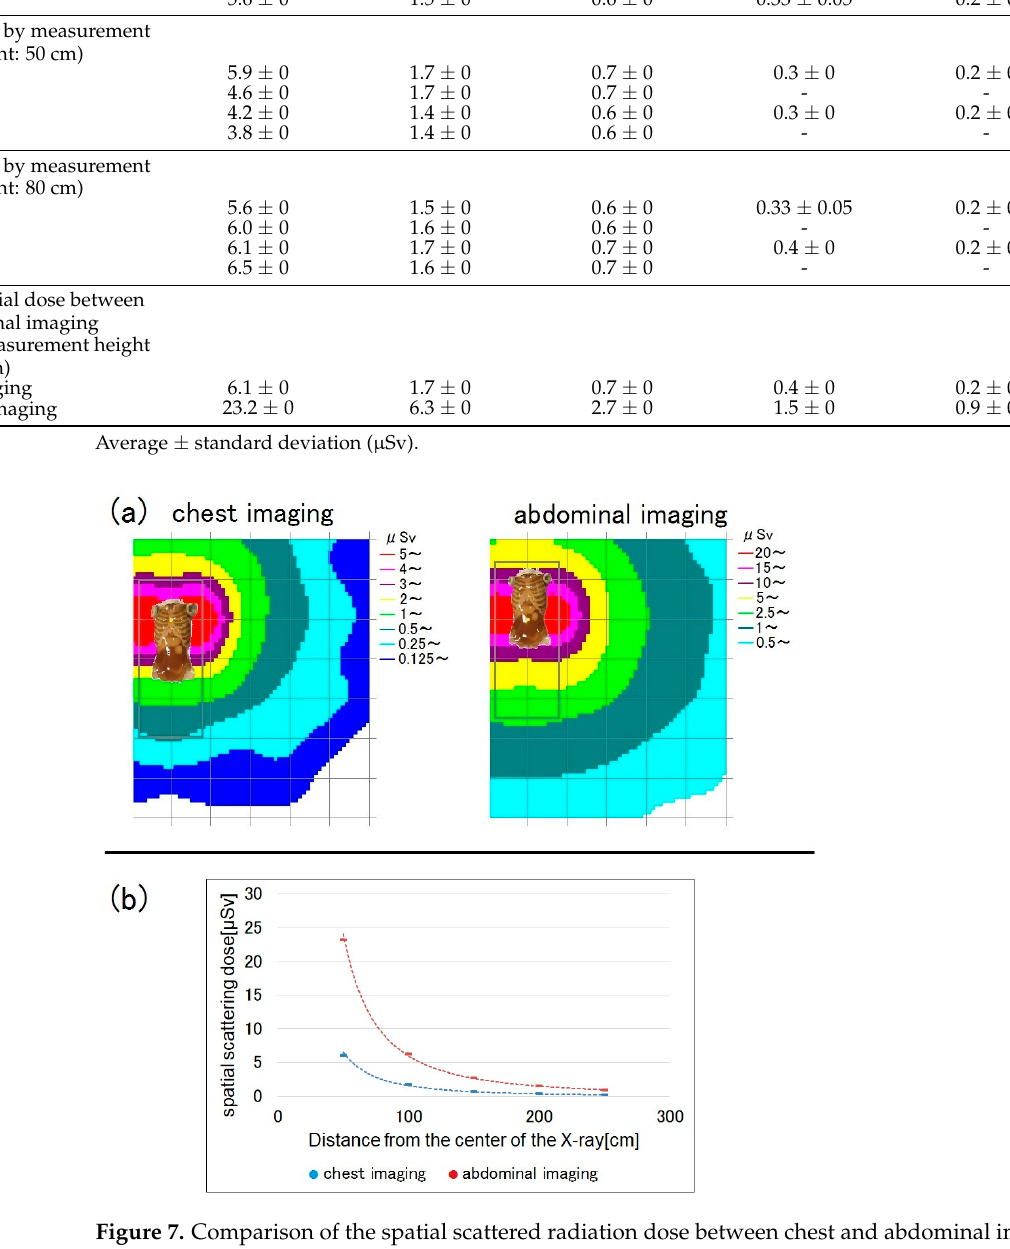
Figure 8. Spatial scattered radiation dose during chest radiography according to X-ray field size (14 × 14 vs. 14 × 17 inches; bed height = 80 cm; measurement height = 150 cm). ( a ) Dose-distribution map and ( b ) graph showing the spatial doses.